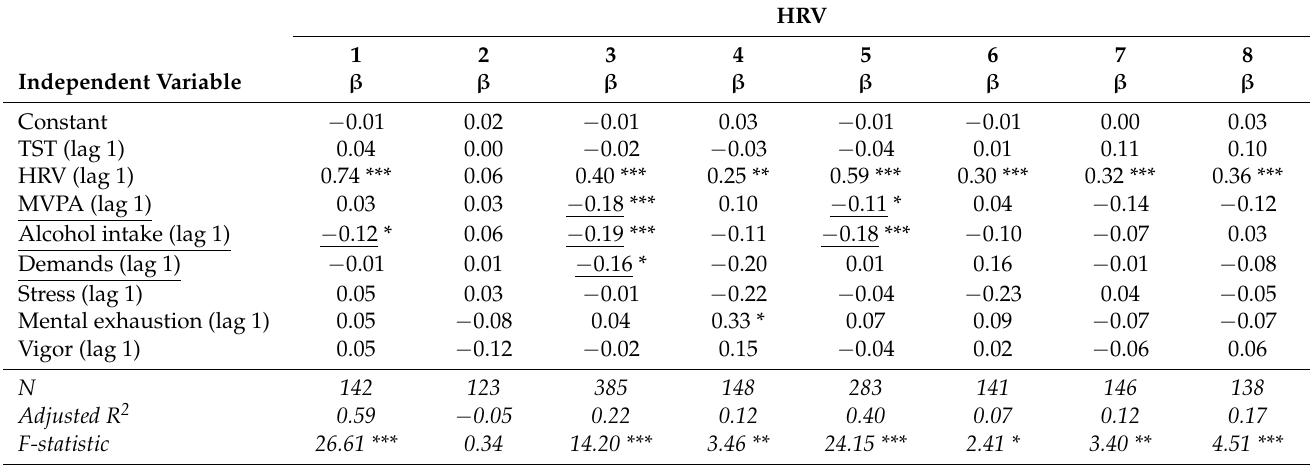
Table 3. Vector autoregression models for Heart Rate Variability (HRV) per participant (1–8).